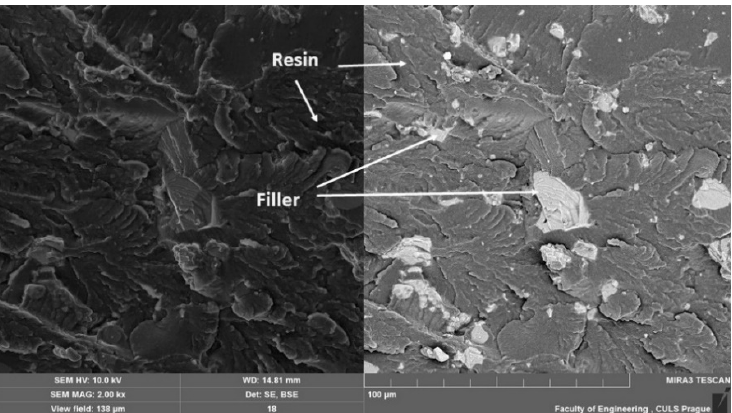
Figure 12. SEM images of fracture surface with filler CaCO 3 calcium carbonate, mixing speed—460 rpm (MAG 2.00 k×). SE figure is shown on the left and the BSE on the right.